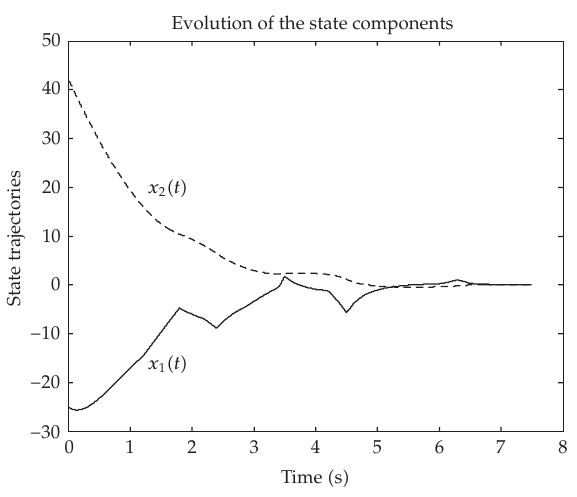
Figure 4: State trajectories for h (cid:8) 0 . 9